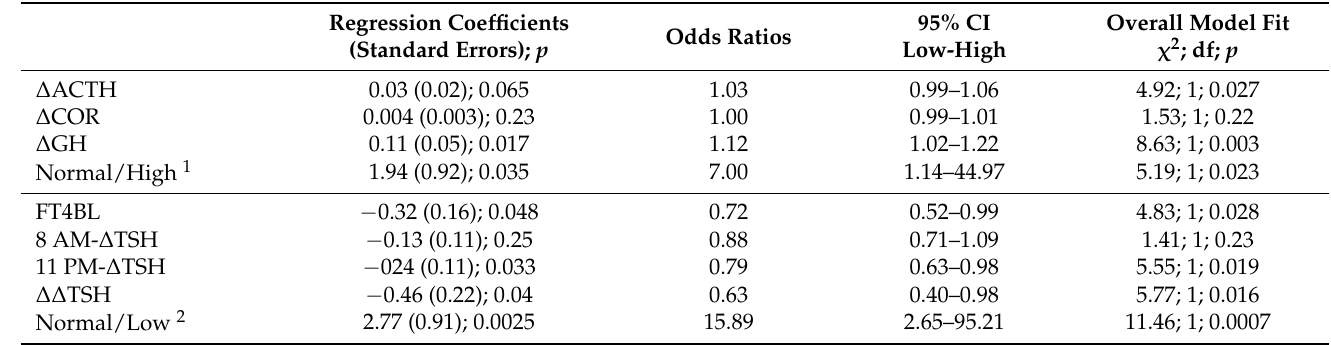
Table 2. Logistic regression analyses between presence (coded 1)/absence (coded 0) of current suicidal behavior disorder (SBD) and apomorphine test responses and hypothalamic-pituitary-thyroid activity in 30 depressed inpatients with SBD.